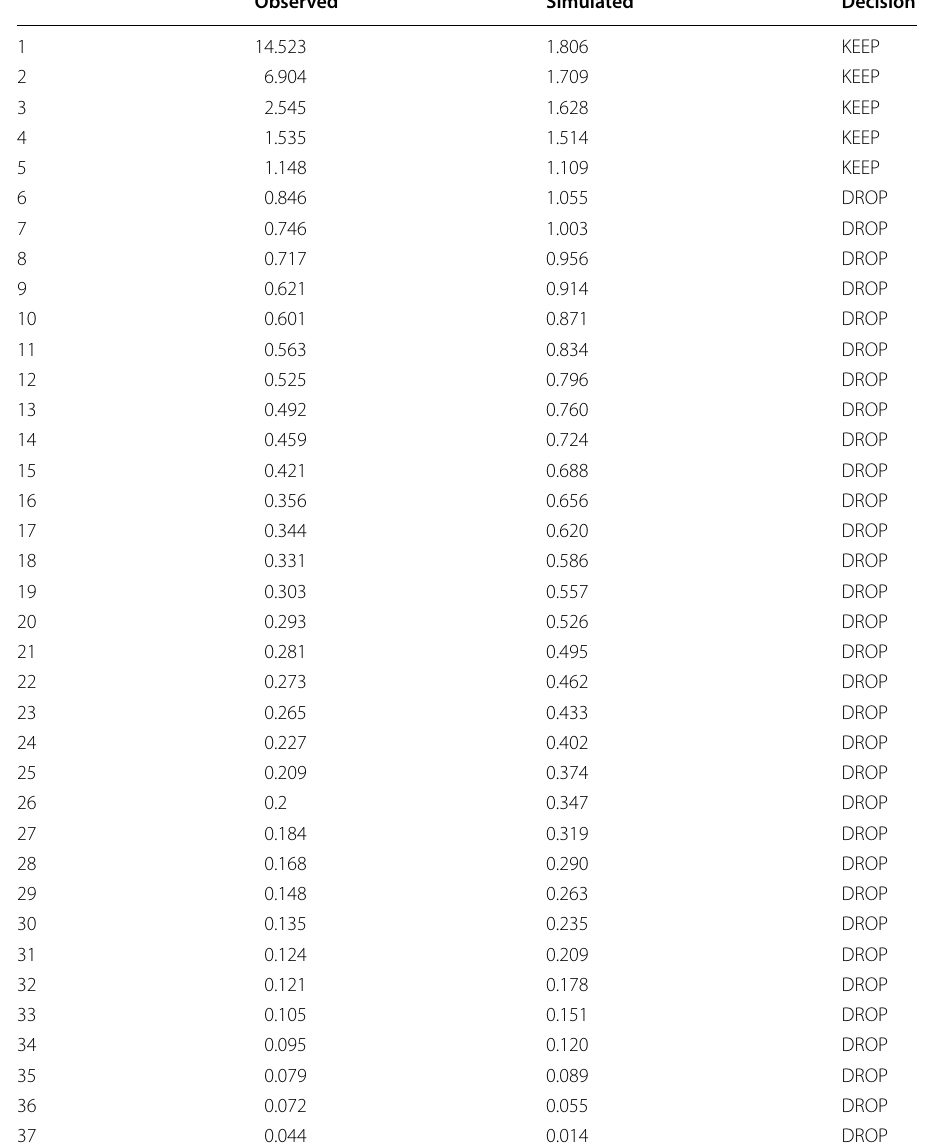
Table 6 Watkins’ parallel